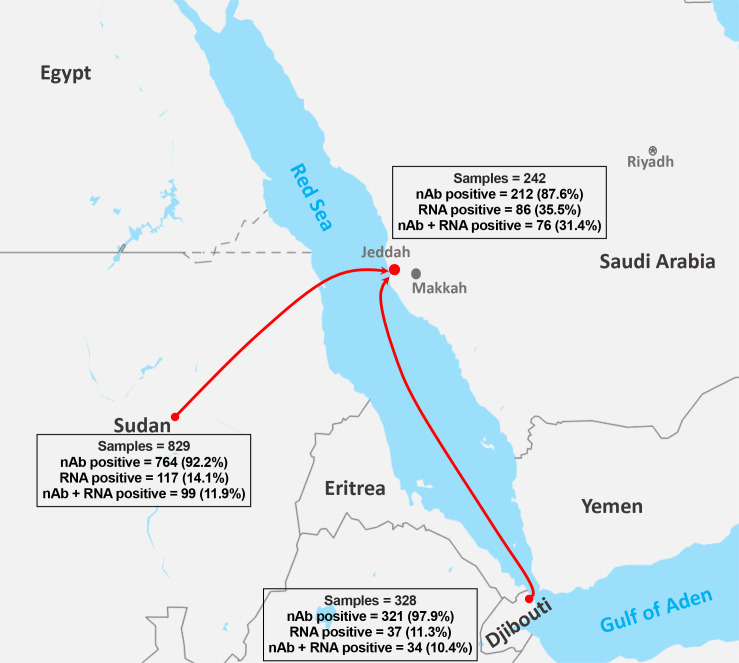
Map of source of collected samples from imported and local dromedary camels.Results from each source is shown as number and percentage of detected nAbs and viral RNA.